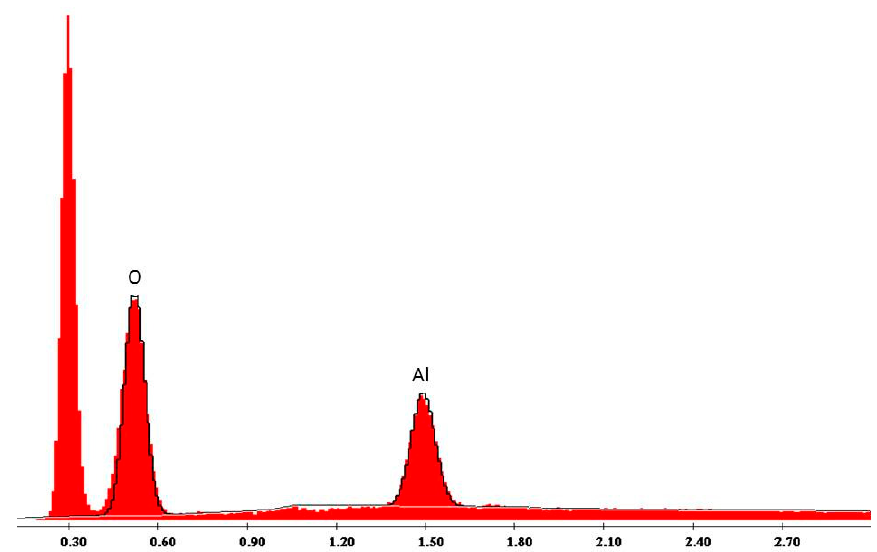
Figure 12. EDAX Analysis of PMMA surface sandblasted with Rocatec Pre only (110 µ m aluminum oxide, 2.8 bar).